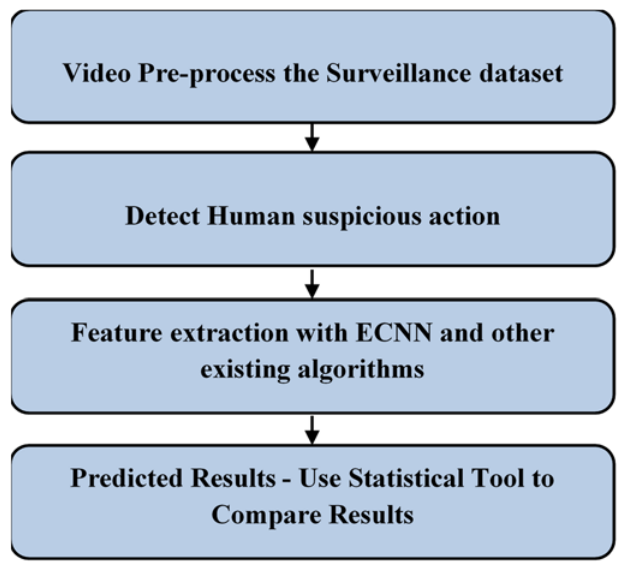
Figure 2. Suspicious-action (shooting-and-stealing) detection steps.